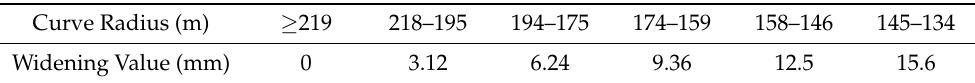
Table 4. Gage widening values used in American railways (mm). Curve Radius